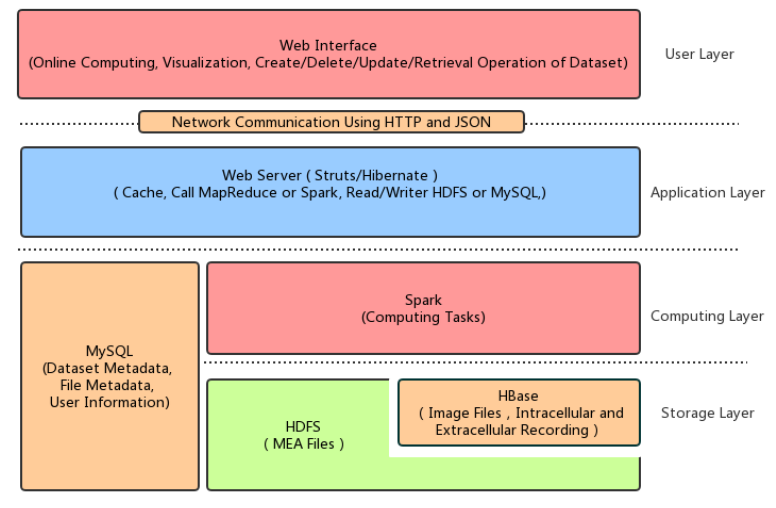
Figure 1. Plant electrophysiological data sharing architecture.